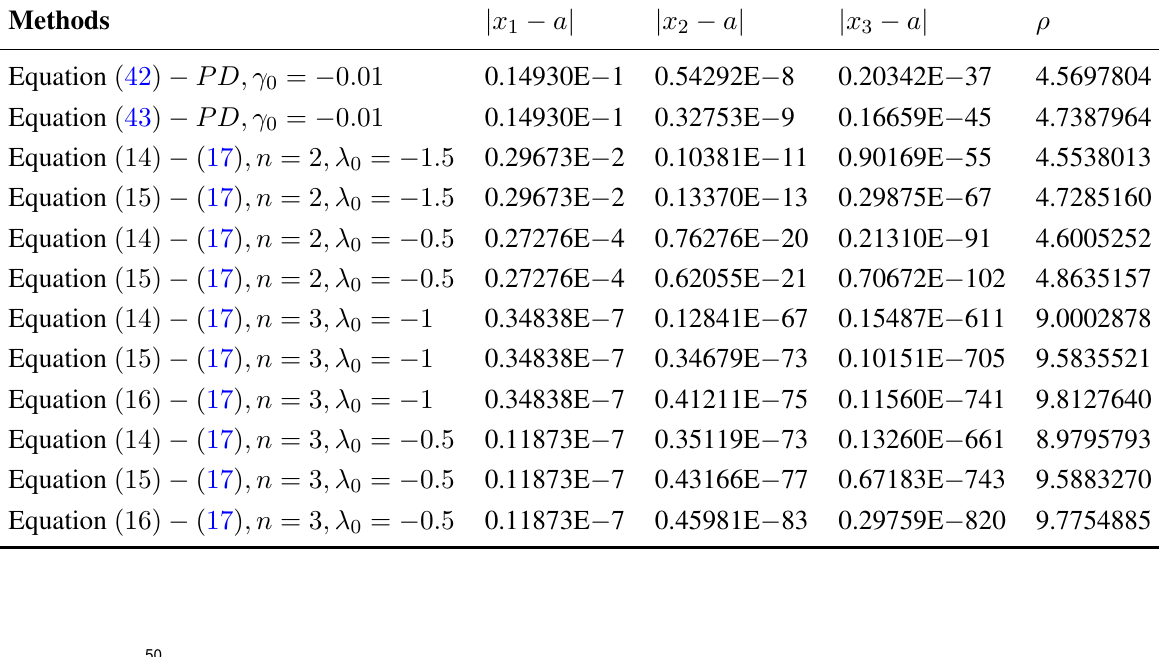
Table 4. Numerical results for f